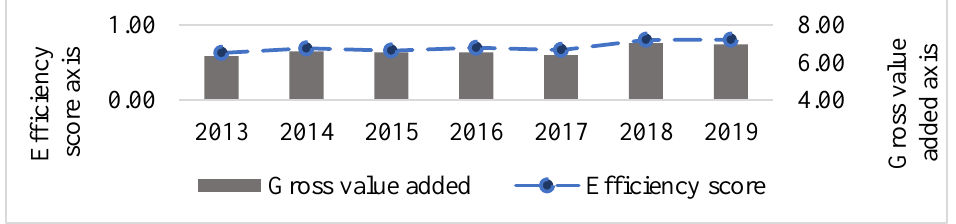
Figure 3. Gross value added (ln) and DEA- based efficiency score. Source: authors’ projection.